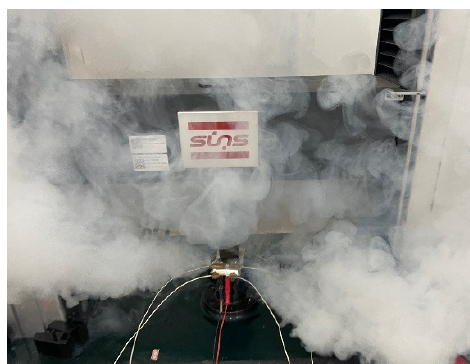
Figure 14. Smoke from the battery.